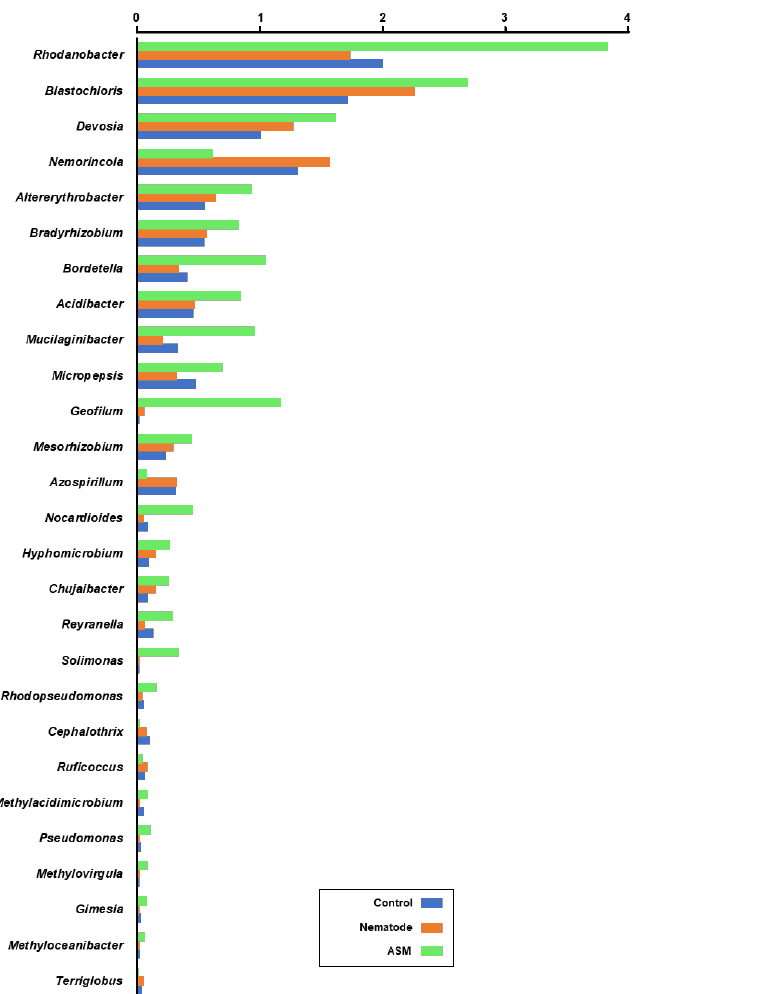
Figure 5. The relative abundance of bacterial genera in the rhizosphere of pine seedling treated with acibenzolar-s-methyl (ASM) and followed by inoculation with the nematode, as compared to nematode-inoculated or control seedlings. Only bacterial genera that existed in significantly different ( p < 0.05) relative abundance after treatment with ASM compared to the control are shown in the graph. The bars represent the mean values ( n =